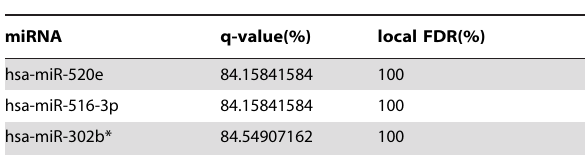
Table 3. SAM test of Luminex miRNA expression data for BD and C only.